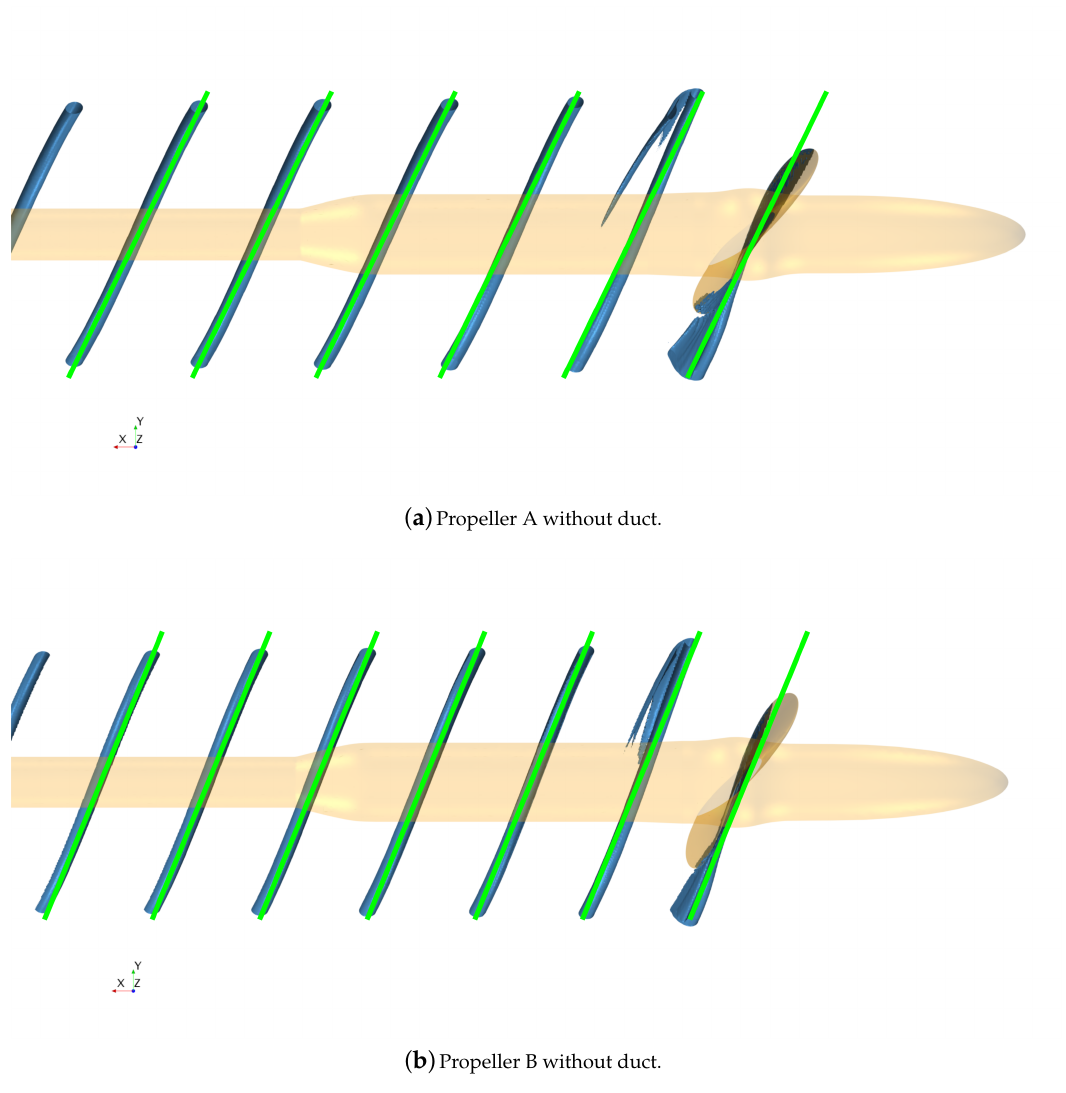
Figure 18. Qualitative analyses of the vortex structures generated by the ductless